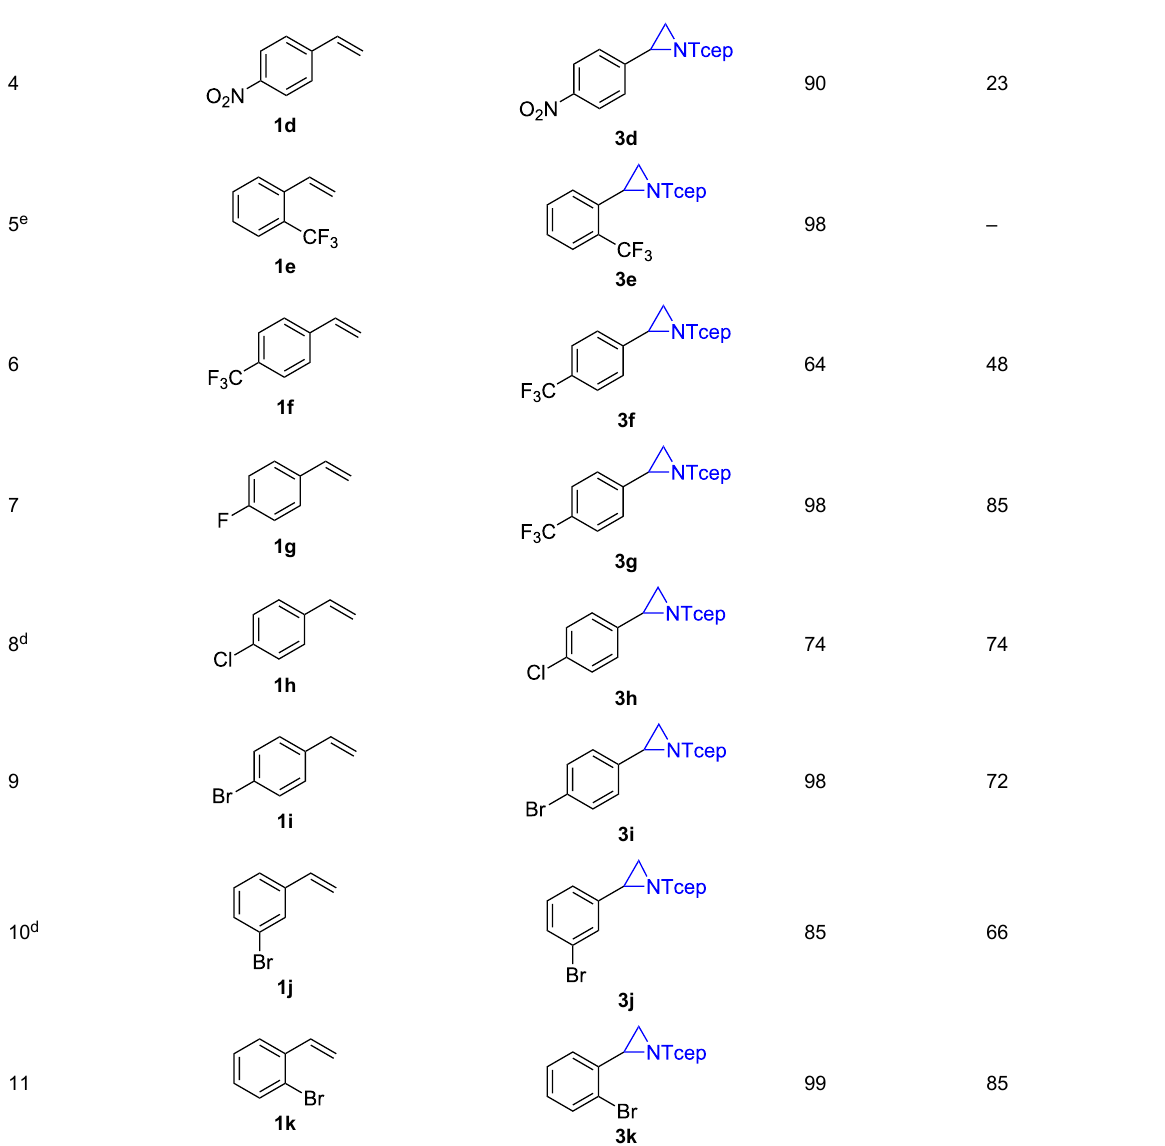
Table 2: Enantioselective aziridination of olefins with TcepN 3 catalyzed by [Co( P6 )]. a